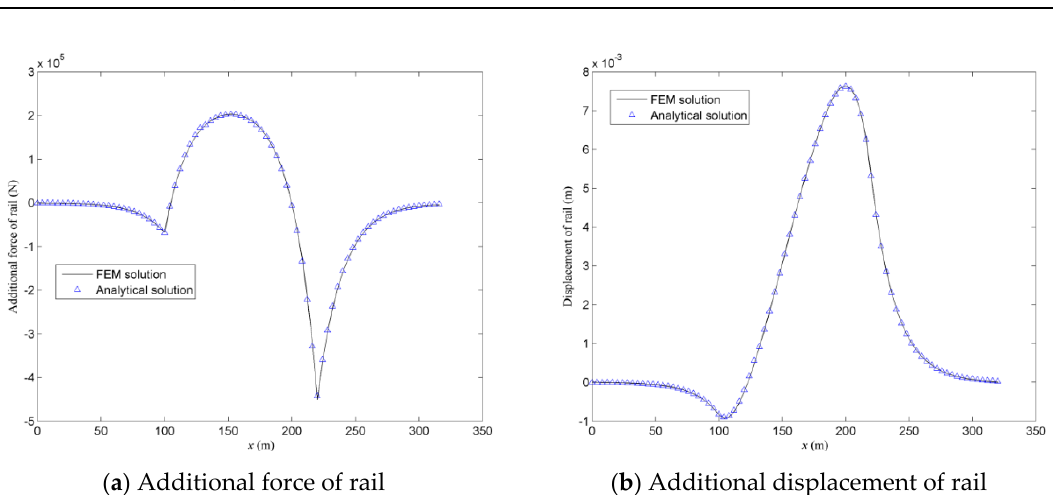
Figure 5. Distribution of the additional force and displacement on the rail.